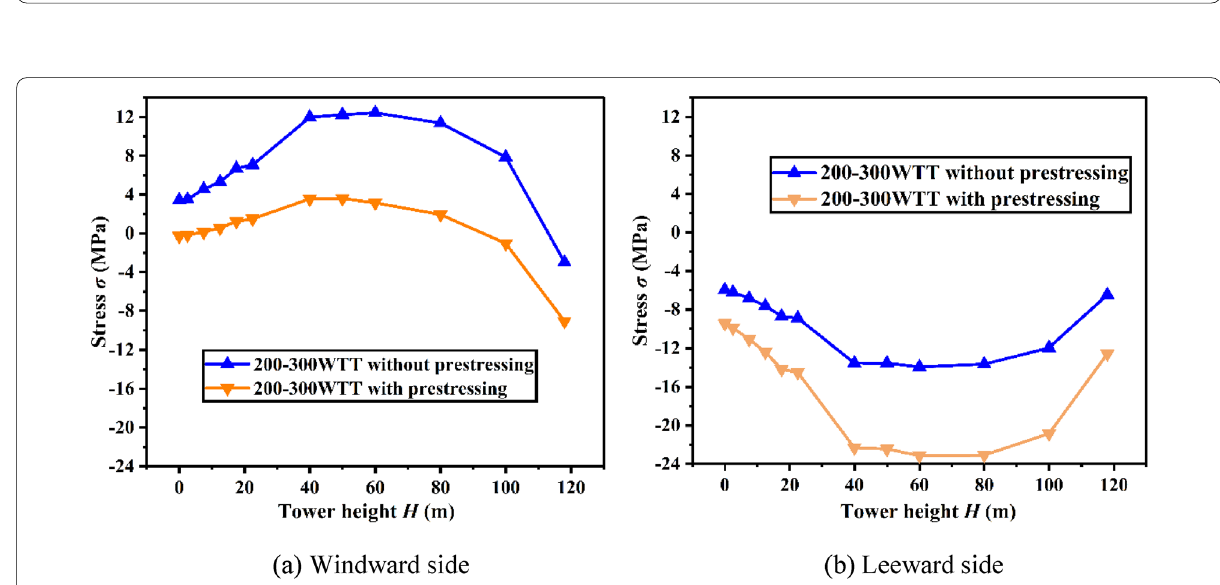
Fig. 11 Stress distribution of UHPC segment in towers with/without